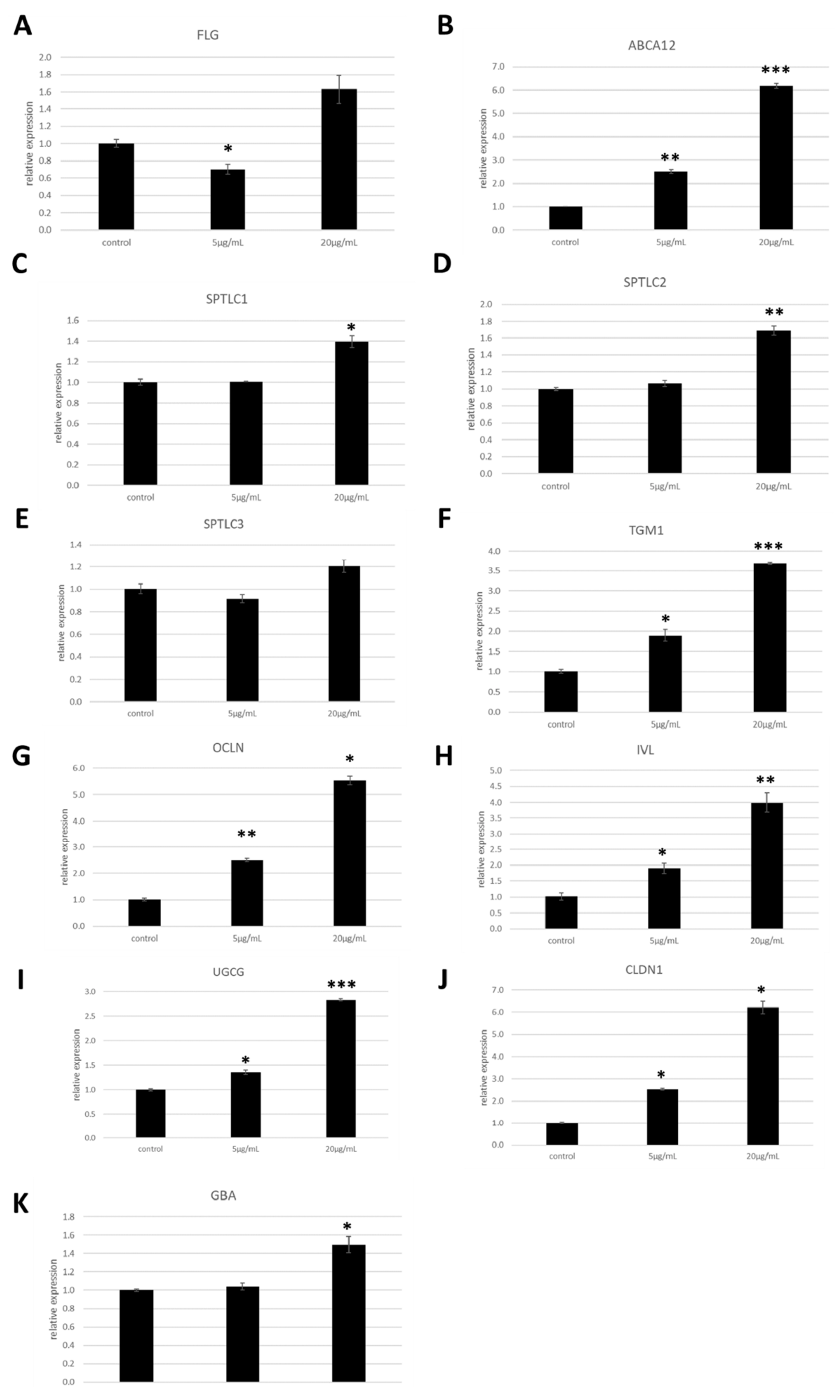
Figure 3. Expression of genes involved in skin barrier function in NHEK cells upon addition of the glycosylceramide purified from Aspergillus luchuensis. NHEK cells were incubated with the glycosylceramide purified from A. luchuensis , and the mRNA expression levels of the indicated genes were measured using qPCR. The results indicated are the mean values ± standard errors. The values on the x -axis indicate the concentration of glycosylceramides ( µ g / mL) added. Statistical significance of di ff erences was determined by the unpaired one-tailed Student’s t -test followed by Bonferroni correction ( n = 3, *, p < 0.05; **, p < 0.01; ***, p < 0.001). ( A ) Filaggrin (FLG); ( B ) ATP-binding cassette sub-family A member 12 (ABCA12); ( C ) serine palmitoyltransferase long chain base subunit 1 (SPTLC1); ( D ) SPTLC2; ( E ) SPTLC3, ( F ) transglutaminase 1 (TGM1); ( G ) occludin (OCLN); ( H ) involucrin (IVL); ( I ) ceramide glucosyltransferase (UGCG); ( J ) claudin 1 (CLDN1); ( K ) glucosylceramidase beta